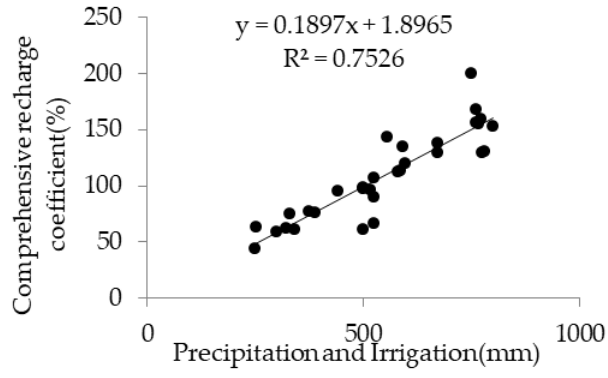
Figure 8. Recharge versus precipitation and irrigation.